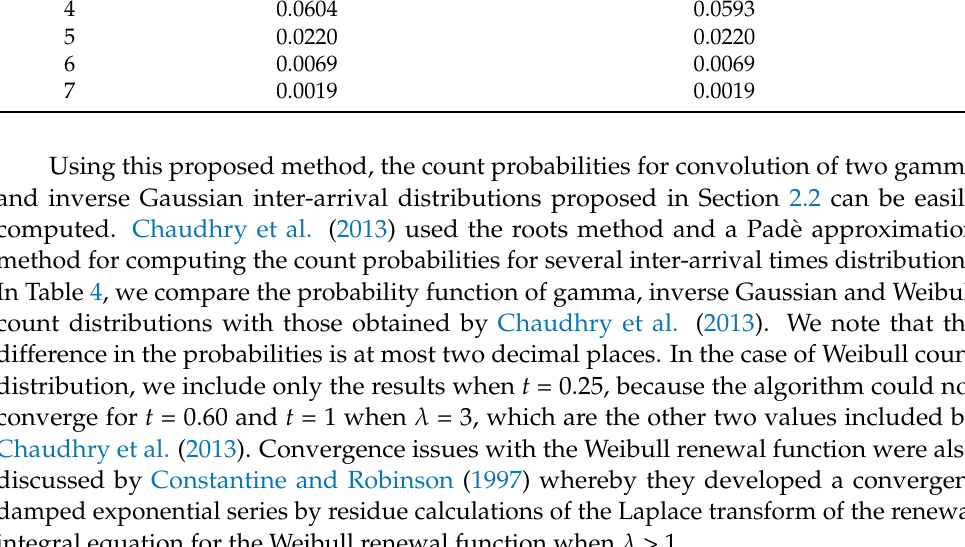
Table 4. Computation of probabilities for ( a ) gamma, ( b ) inverse Gaussian, and ( c ) Weibull